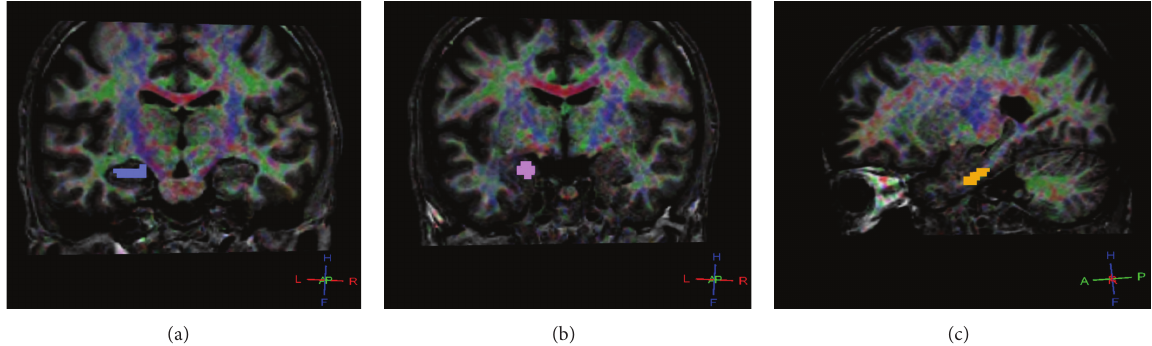
Figure 2: Examples of ROI placements on the hippocampus (a), the amygdala (b), and the parahippocampus (c) obtained from a 33-year-old